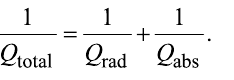
changed along the y direction ( P y is still a ), the dispersion along k y is also located above the light cone and resembles the profile of f 0 ( k x , k y ) along the X Μ direction. A weaker spatial disper- sion of the QGMs is present in the k y direction compared to the k x direction, which is the same as for the